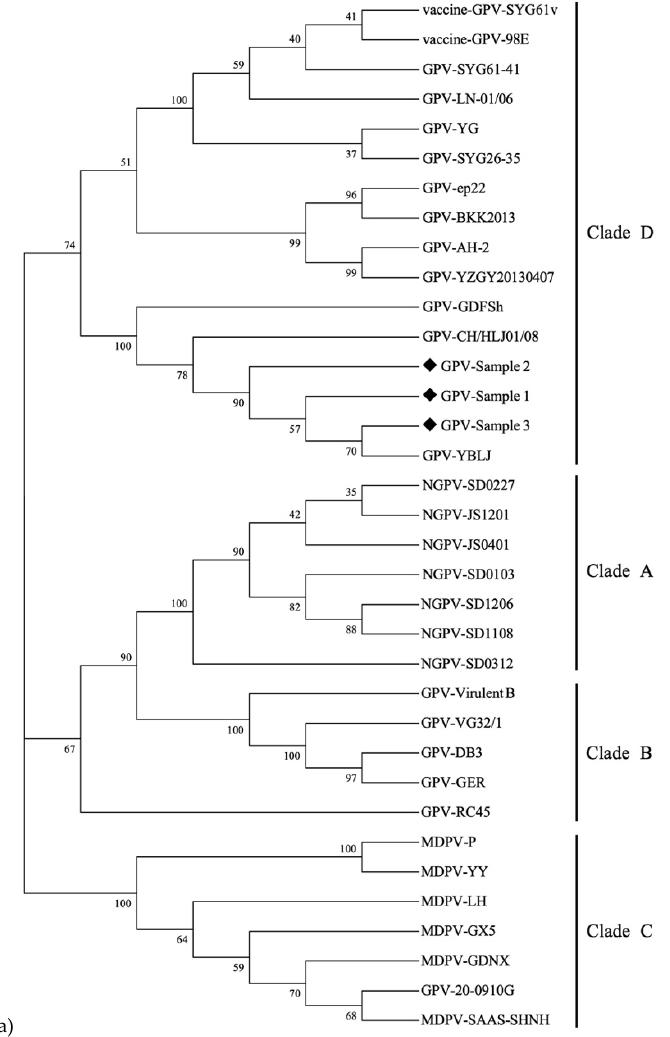
Lane 1–8 and 10–16, GPV clinical samples; Lane 17, healthy